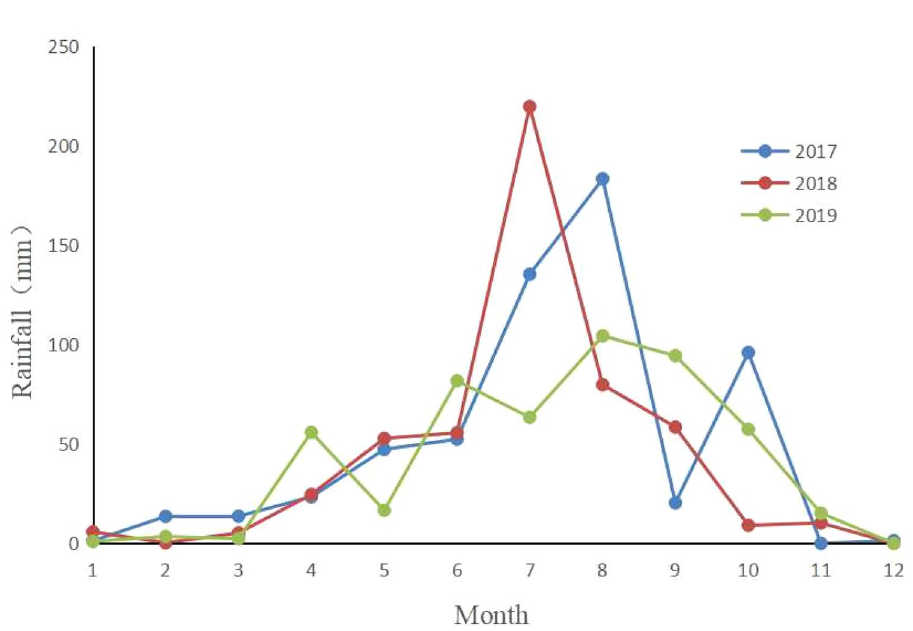
Figure 1. Distribution of the monthly precipitation in